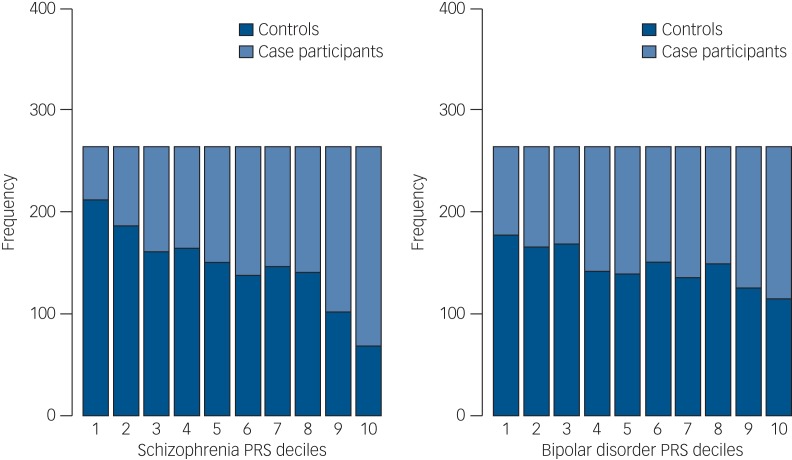
Case and control distribution in the risk polygenic score (PRS) deciles. The Y-axis corresponds to the number of individuals in each PRS decile. The P-value threshold used to calculate PRS was PT = 0.05. Based on their PRS, samples were allocated to deciles (decile 1, lowest PRS; 10, highest PRS). The figure shows that especially for schizophrenia PRSs the effect is concentrated in the tails of the distribution (deciles 1–2 and 9–10). There is very little difference between the deciles 4–7 in the middle, as is expected from a normal distribution.